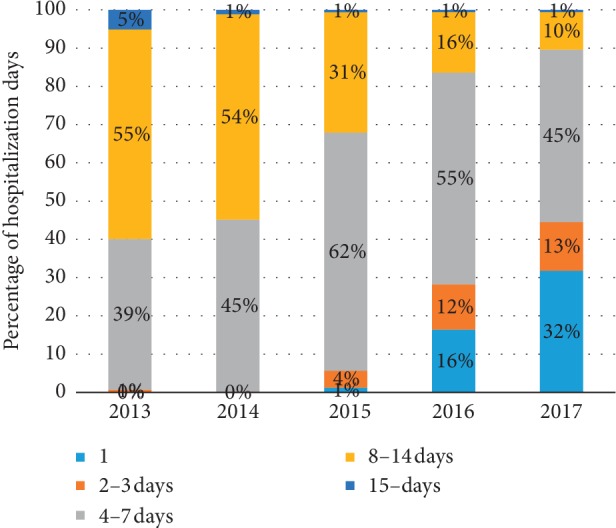
Trend of the changes in the number of days of hospitalization recorded at the study location over the past five years.